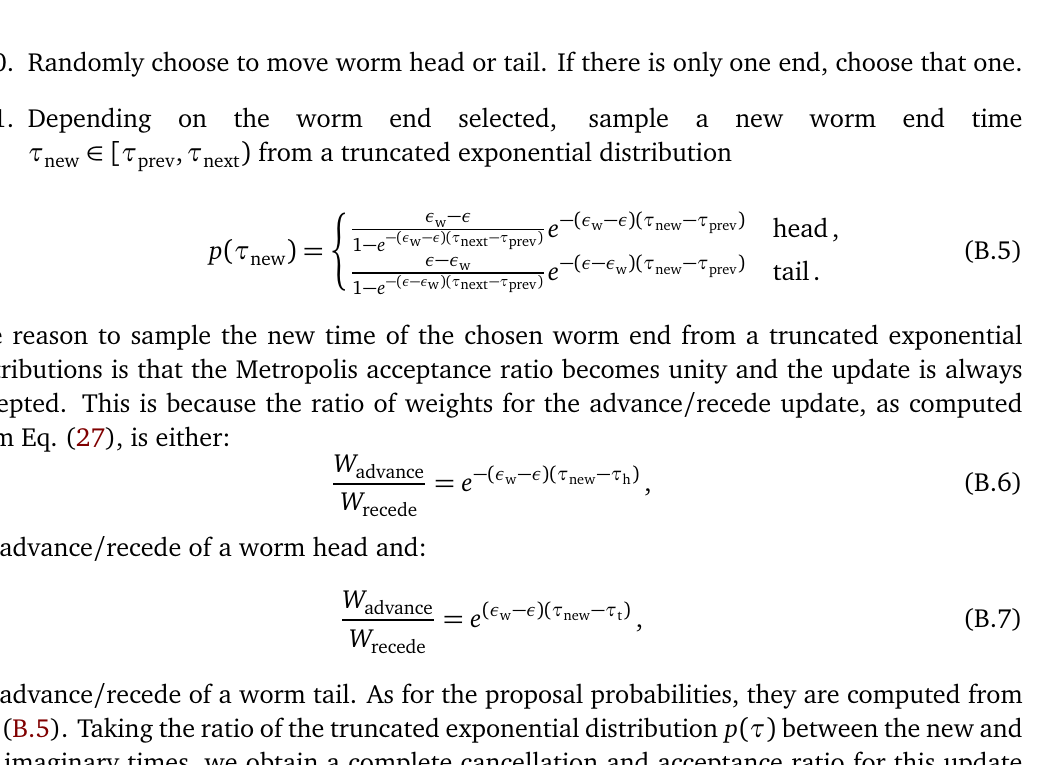
Figure 16: Advance / Recede. Worm end is selected at random. It is then moved to a randomly sampled time inside the flat interval. The diagram above illustrates the example of advancing / receding a head in imaginary time. Either the worm head or tail can be